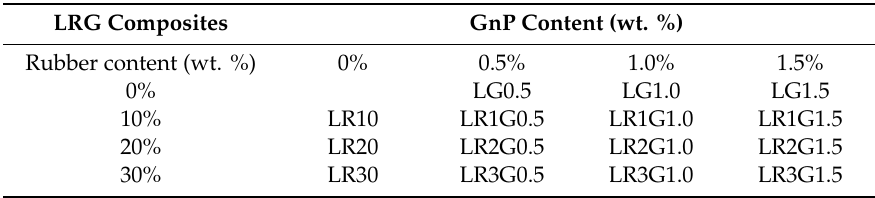
LRG: Epoxy + rubber + graphene